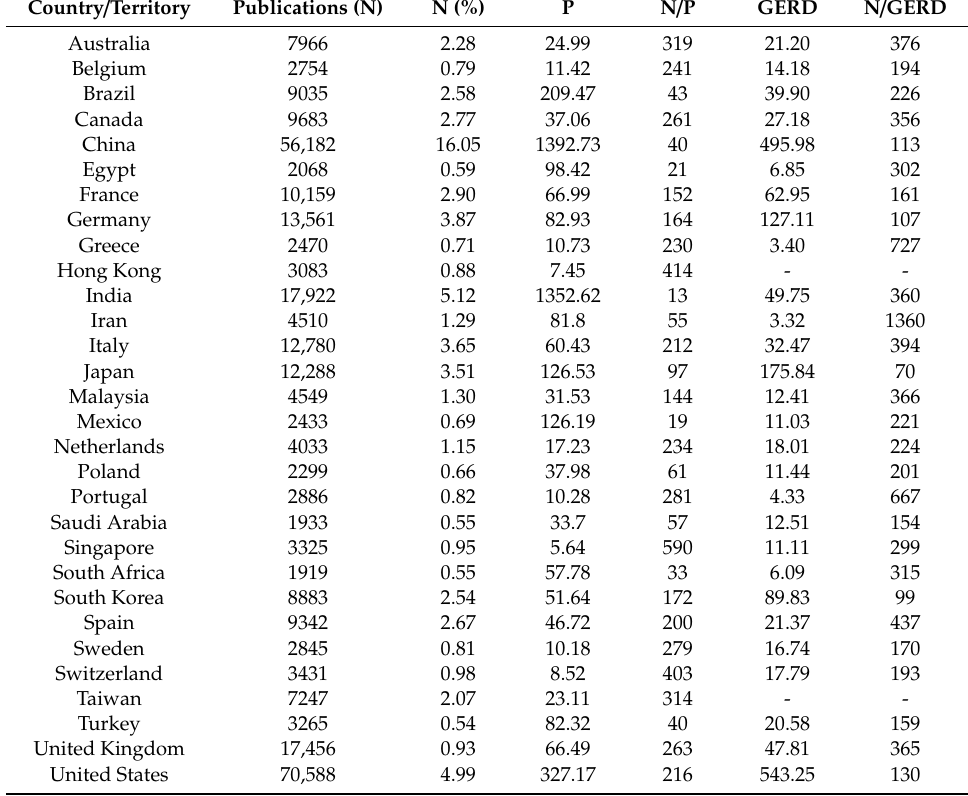
Figure 5. Worldwide research on low cost. Table 1. Top 30 countries publications (N) their population (P) in millions of inhabitants and their Gross domestic expenditure on R&D (GERD) in billions of dollars.